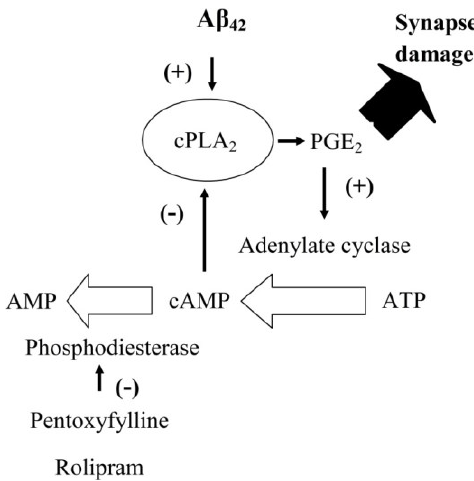
Figure 8. PGE 2 reduces Aβ and αSN-induced activation of synaptic cPLA 2 : The amounts of activated cPLA 2 in synaptosomes pre-treated for with control medium (○), 1 nM PGE 2 (●) or 1 nM PGD 2 (■) and incubated with Aβ 42 ( A ) or αSN ( B ) as shown. Values are means ± SD from triplicate experiments performed 3 times ( n = 9).